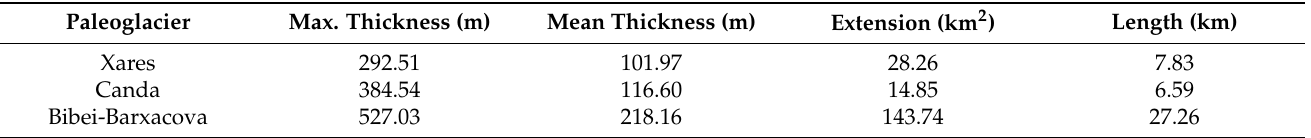
Table 4. Main characteristics of paleoglaciers.